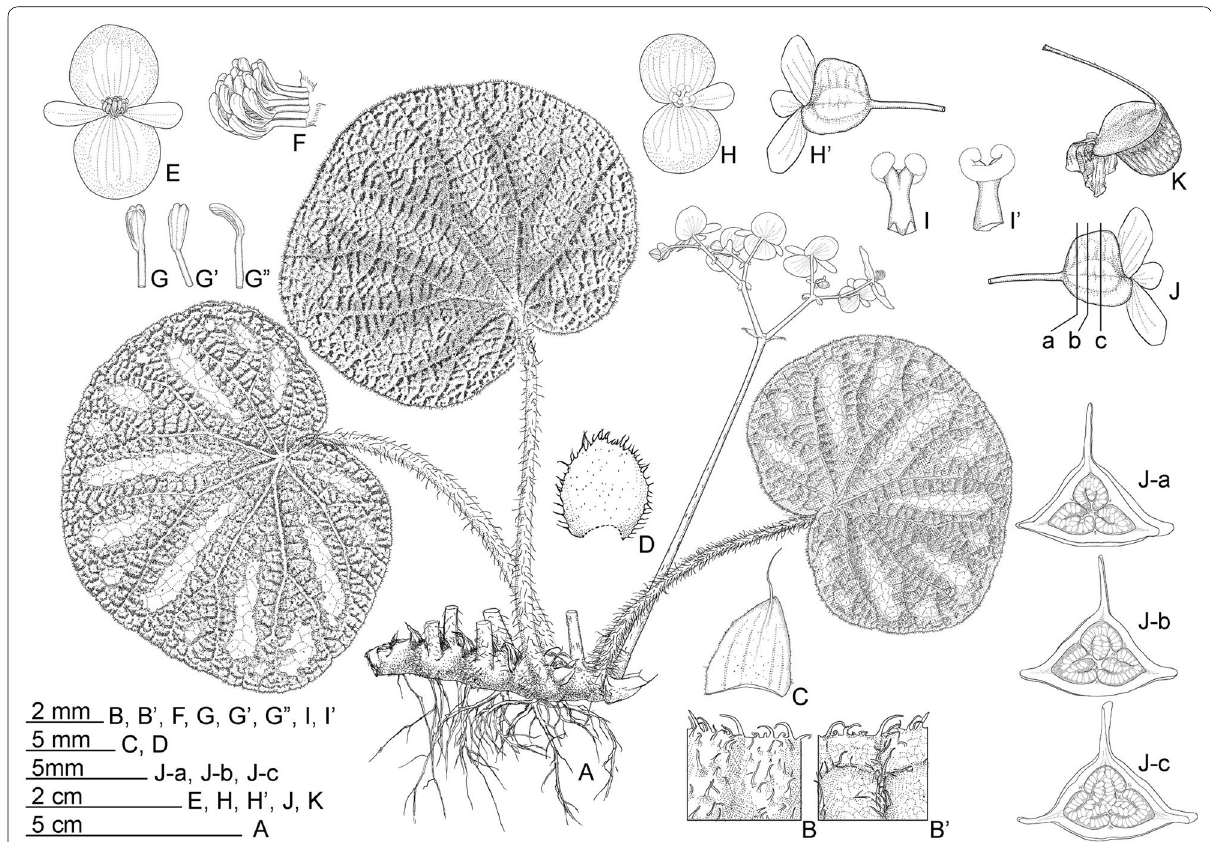
Fig. 10 Begonia lui S.M.Ku, C.I Peng & Yan Liu. A Habit; B Leaf adaxial surface; B’ Leaf abaxial surface; C Stipule; D Bract; E Staminate flower, face view; F Androecium, side view; G , G’ , G” Stamens; H , H’ , Pistillate flower; I , I’ Stigmas; J-A – J-C Serial cross section of ovary; K Capsule. All from